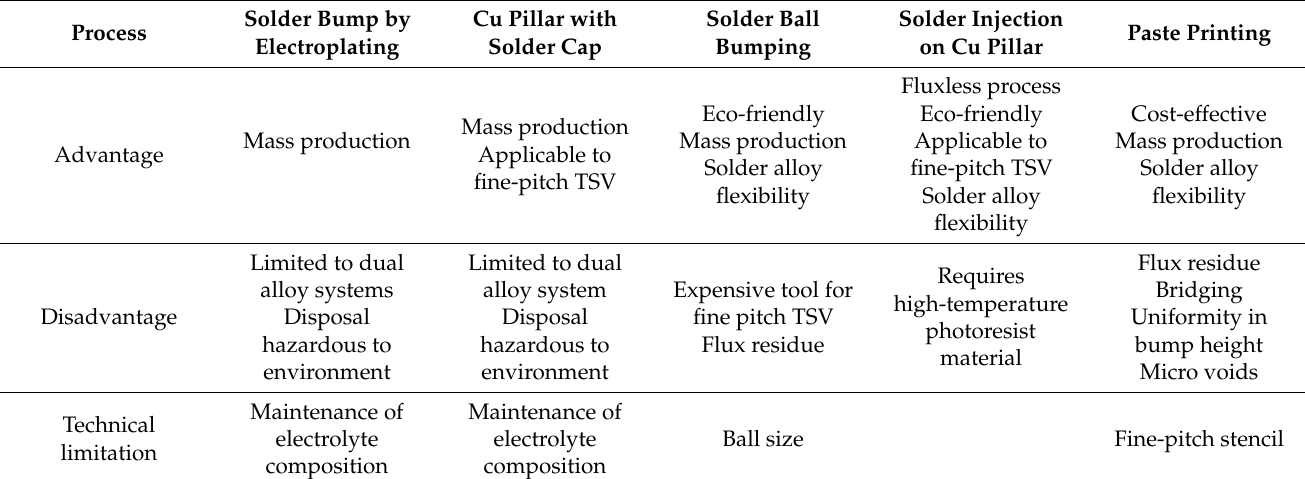
Figure 22. Schematic illustration of solder paste printing on TSV. Table 1. Comparison of solder bumping